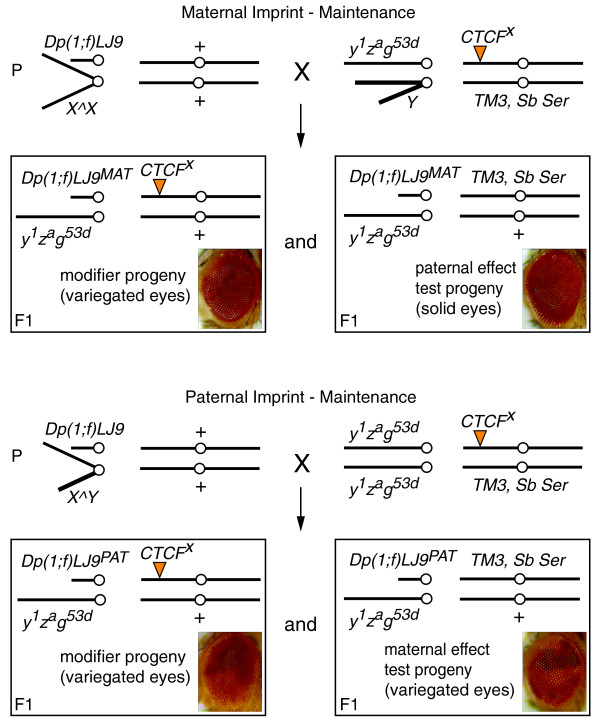
Mating schematic for testing the effect of dCTCF on the maintenance of the Dp(1;f)LJ9 imprint. Two sets of progeny are generated from this cross: progeny that have independently inherited the Dp(1;f)LJ9 mini-X chromosome and a CTCFX mutant allele (modifier progeny) and progeny that have inherited Dp(1;f)LJ9 and the TM3, Sb Ser balancer, but had a parent carrying a CTCFX mutant allele (maternal and paternal effect test progeny).